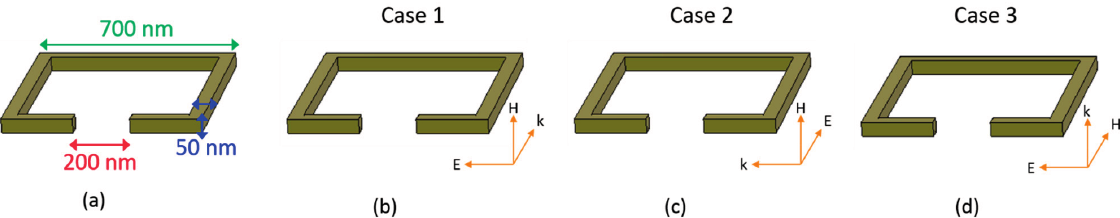
Figure 1. ( a ) Dimensions of the 1-SRR: L = 700 nm, W = 50 nm, T = 50 nm, and G = 200 nm ( b ) Case 1: electric field in-plane and along the gap, magnetic field out-of-plane ( c ) Case 2: electric field in-plane and normal to the gap, magnetic field out-of-plane (c) Case 3: electric and magnetic fields in-plane, along the gap and normal to it, respectively. All the gold SRRs are described using the Drude model with a plasma frequency ( ω p = 1.367 × 10 16 rad/s) and collision frequency ( ω c = 6.478 × 10 13 rad/s) based on values from